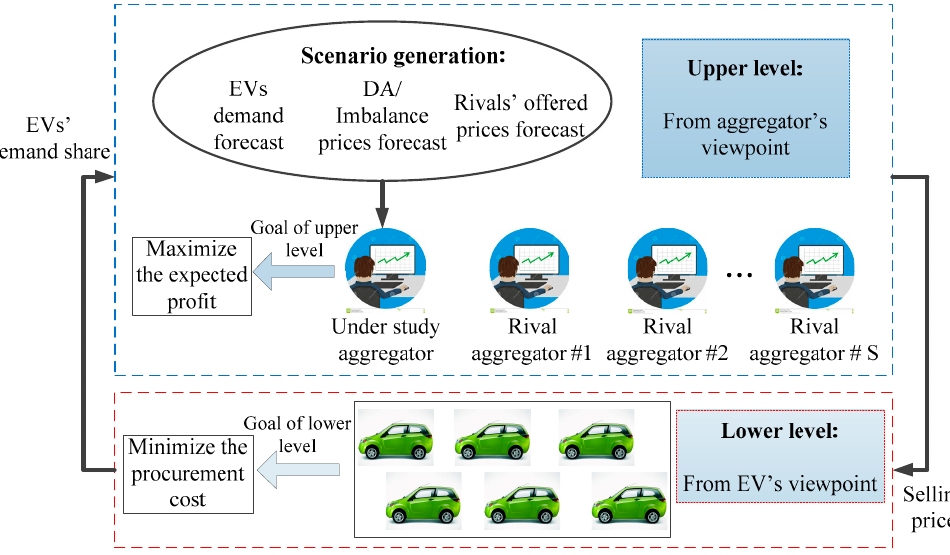
Figure 1 . Bi-level framework of the problem. Figure 1. Bi-level framework of the